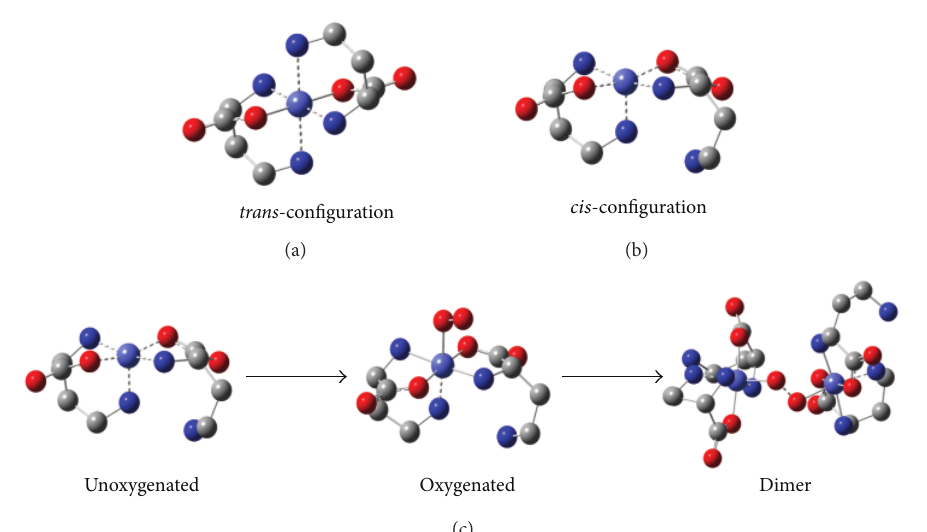
Figure 10: ((a), (b)) Two proposed deoxygenation configurations of Co(DABA) 2 and (c) simulation of oxygenation of Co(DABA) 2 .